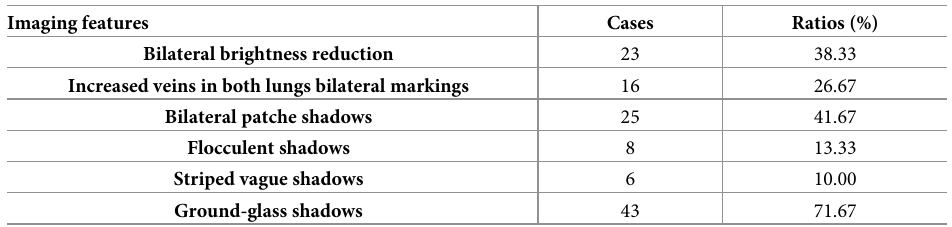
Table 2. Radiological imaging characteristics of the 60 patients with AIDS-PCP.